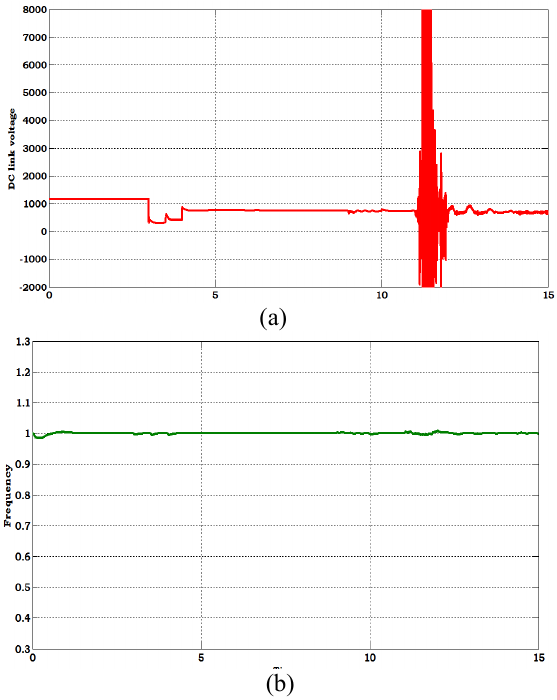
Figure 25. (a). DC link voltage, (b).Frequency Other units are suddenly connected at t=12sec, hence small disturbance observed in DC link voltage but controller brought back voltage in accurate constant value and frequency also maintained with in the limit perfectly. Test Case 4: When operating system in grid connected mode with sudden fault.